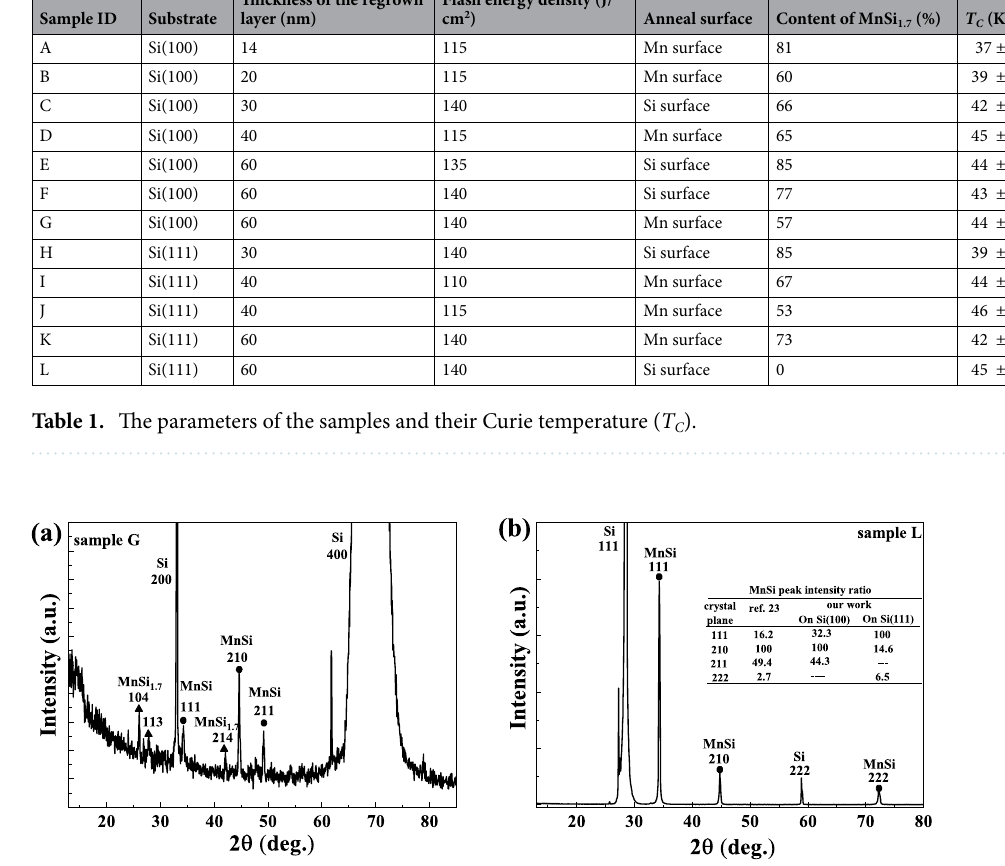
Figure 1. ( a ) XRD pattern of a 60 nm MnSi film on Si(100) by FLA. B20-MnSi and MnSi 1.7 phases coexist. ( b ) XRD pattern of a 60 nm MnSi film on Si(111) by FLA, and in this sample B20-type MnSi is the single phase. The insert table in ( b ) shows the relative intensity ratio of different diffraction planes. Ref. 23 shows the (210) and (211) planes should be the two strongest peaks. Sample G shows consistent with Ref. 23 , indicating a polycrystalline structure. The (111) plane of sample L is the strongest peak, meaning the (111)-textured of this